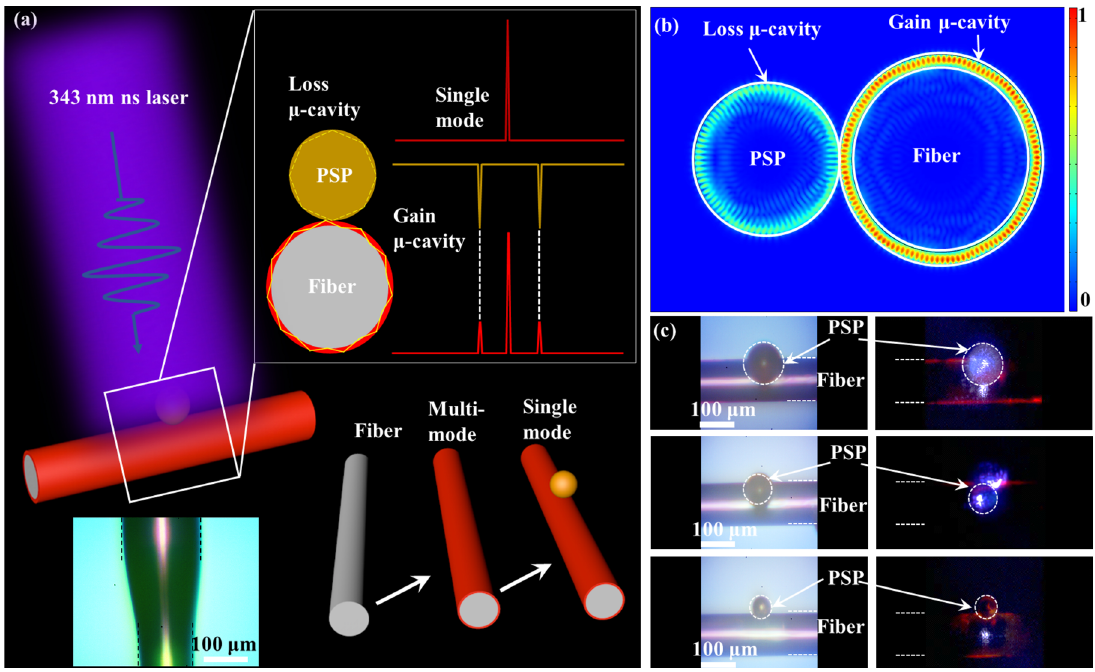
Figure 1: Mechanism of mode selection in the coupled μ -cavity. (a) A schematic illustration of the fabrication progress and mode selection in hybrid 2D – 3D μ -cavity. (b) Numerically simulated electric field distributionofthemodesinthecoupledsystem,indicatingthemodeselectionmechanisminthecoupledresonators.(c)Theopticalimagesof bright field (left) and dark field (right) and the same diameter of polymer fiber with different diameters of PSP.